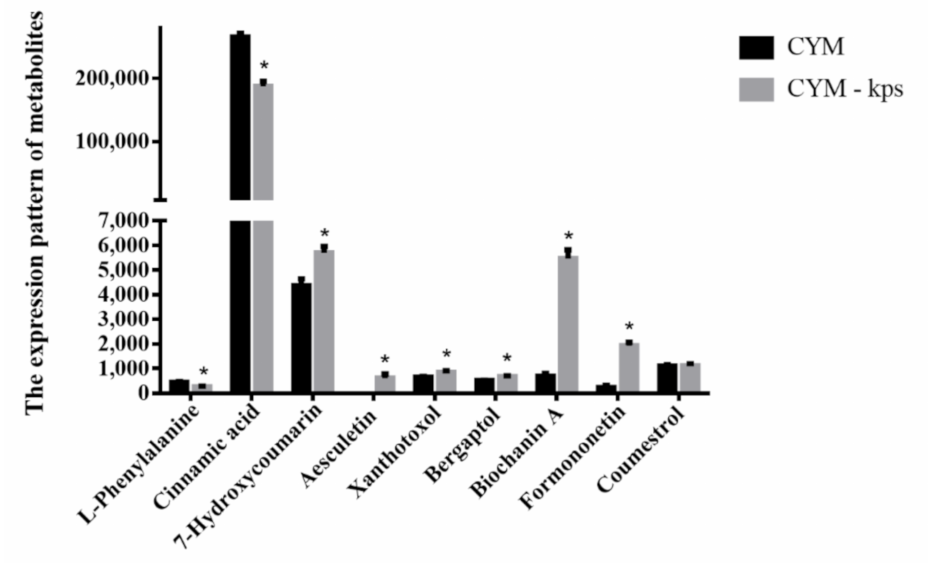
Figure 4. The expression pattern of metabolites identified in A.